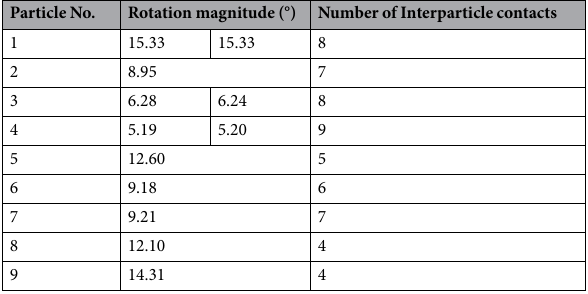
Table 1. Cumulative rotations of individual particles in RoI1 over the first five sintering